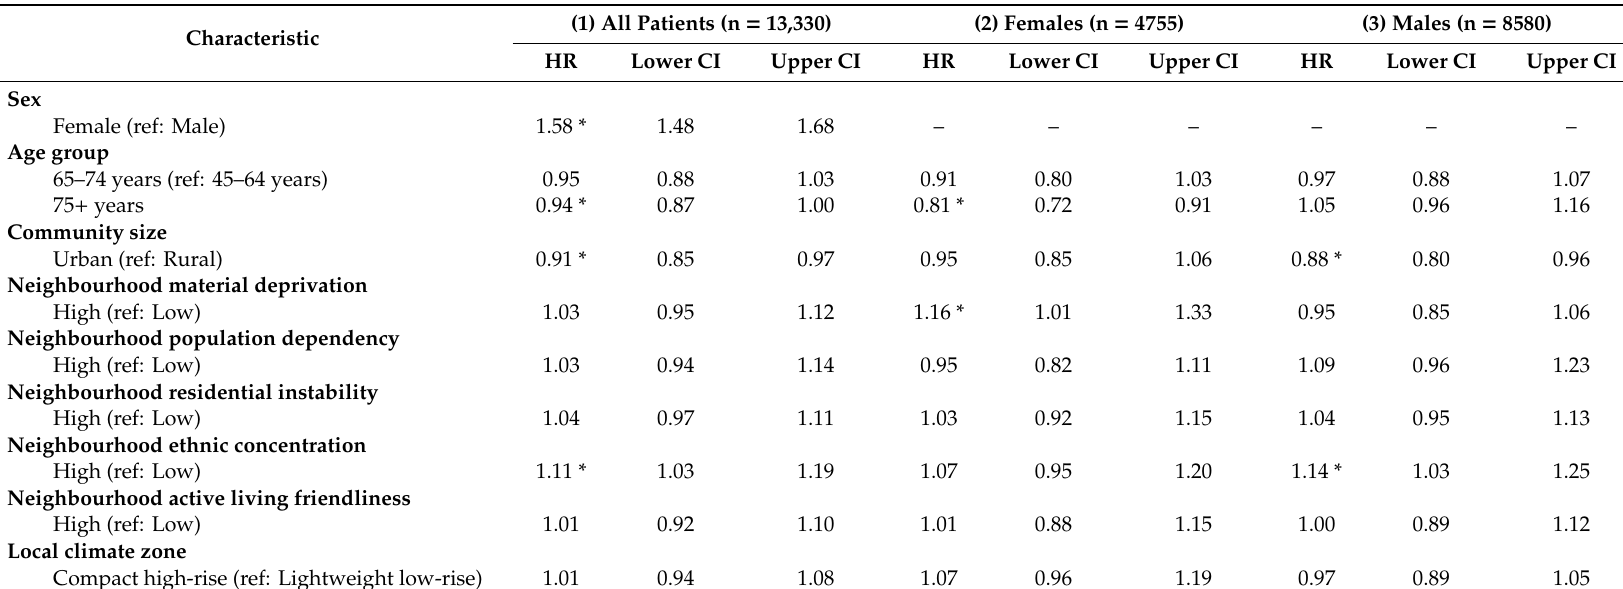
Table 1. Adjusted hazard ratios (HRs) and 95% confidence intervals (CIs) for associations between individual and neighbourhood characteristics and risk of healthcare use for mood and anxiety disorders among AMI patients aged 45 and over; total and by